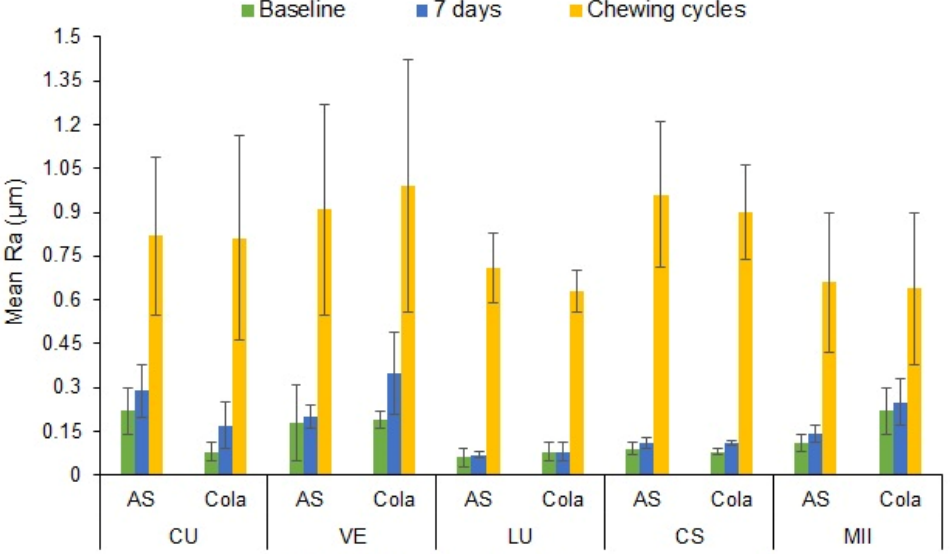
Figure 4. Mean surface roughness (Ra) of the CAD/CAM materials immersed in AS and cola at baseline and 7 days of immersion in either AS or cola, and after the chewing cycles. Bars indicate standard deviation.